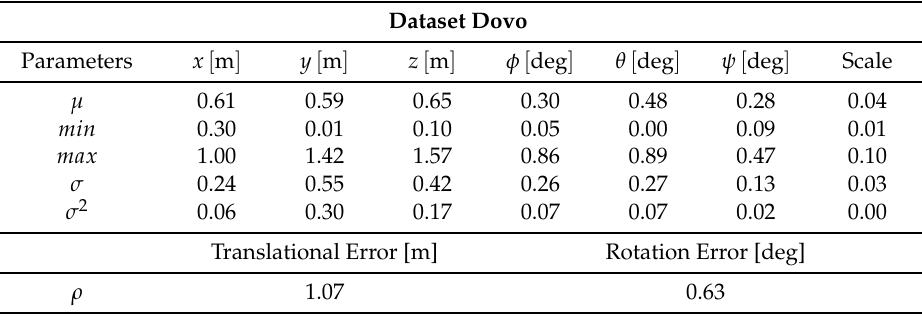
Table 1. Analytical representation of the results with good pre-selected corresponding points (Dataset